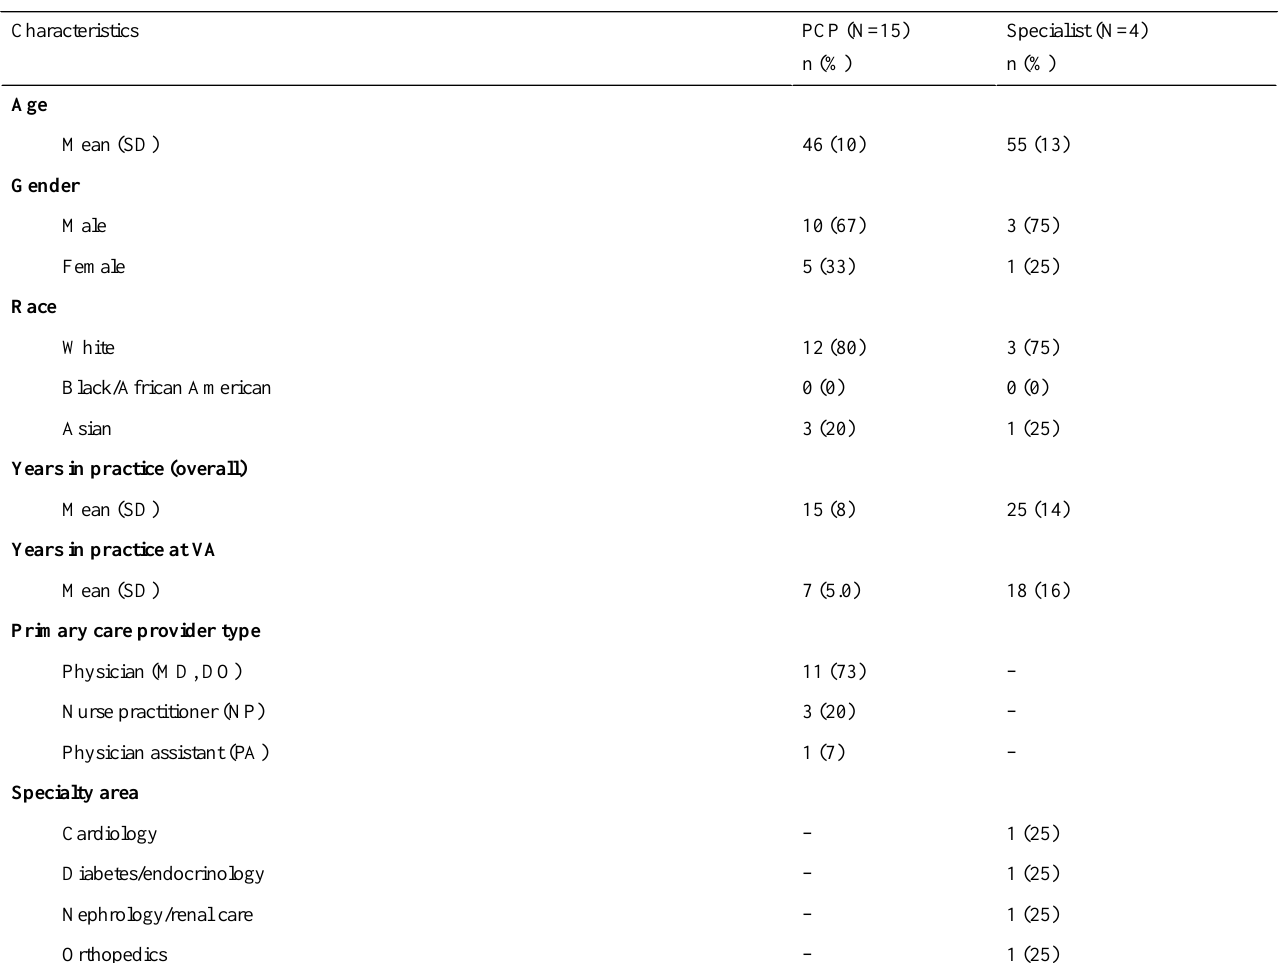
Table 2. Primary Care Provider (PCP) and Specialty Physician Characteristics.